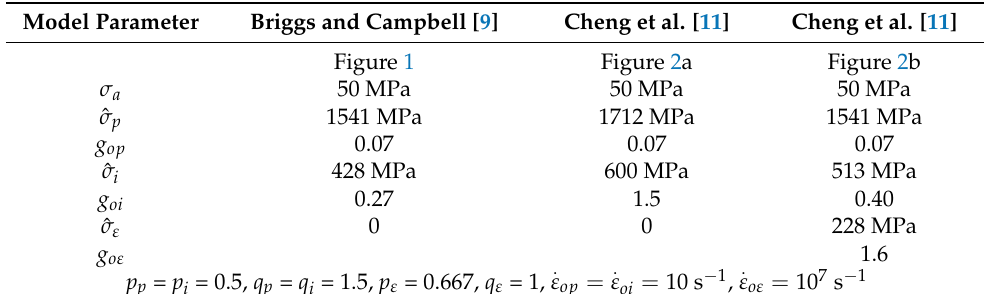
Figure 2. Measurements by Cheng et al. [11] analyzed according to Equations (2) and (3). ( a ) possible model fit and comparison to Briggs and Campbell fit; ( b ) model fit assuming ˆ σ ε = 228 MPa. Table 1. Model parameters for Figures 1 and